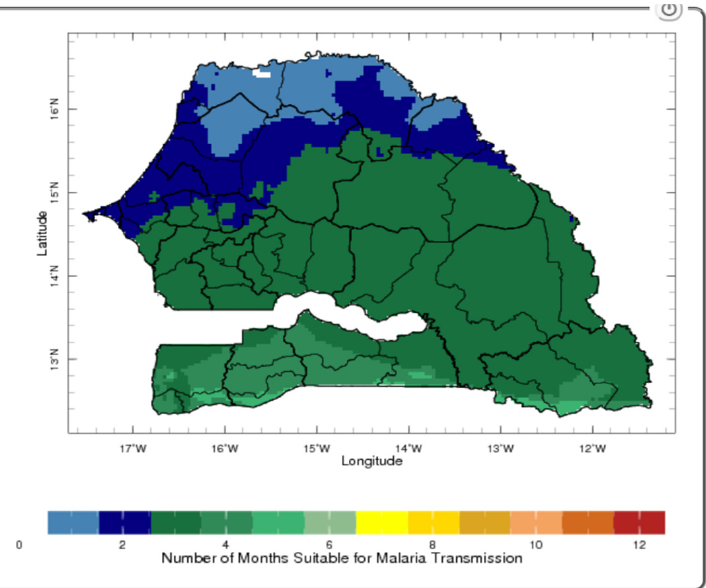
Figure 11. Number of months when the climate is suitable for malaria transmission over Senegal.